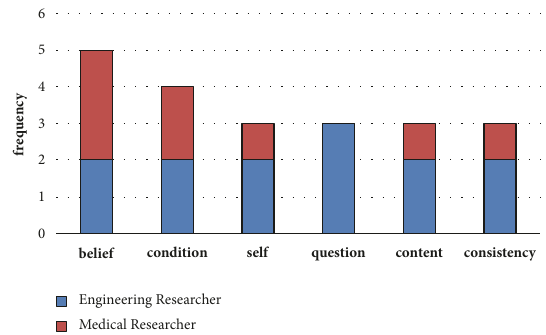
Figure 6: The frequency of terms shared by more than two researchers.